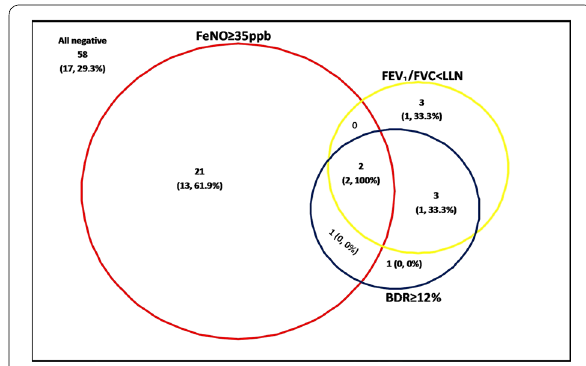
Figure 2 Venn diagram showing number of children with symptoms (n163) who were positive for each combination of